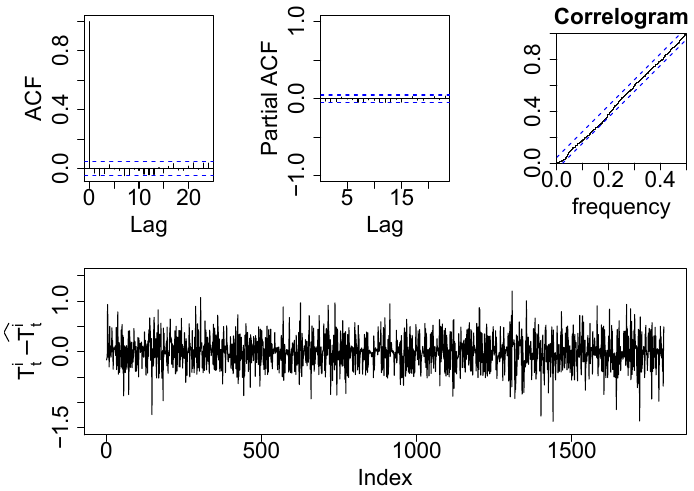
Figure 7. Training residuals of the model with T i as output. Table 1. Model coefficients configuration for each exogenous